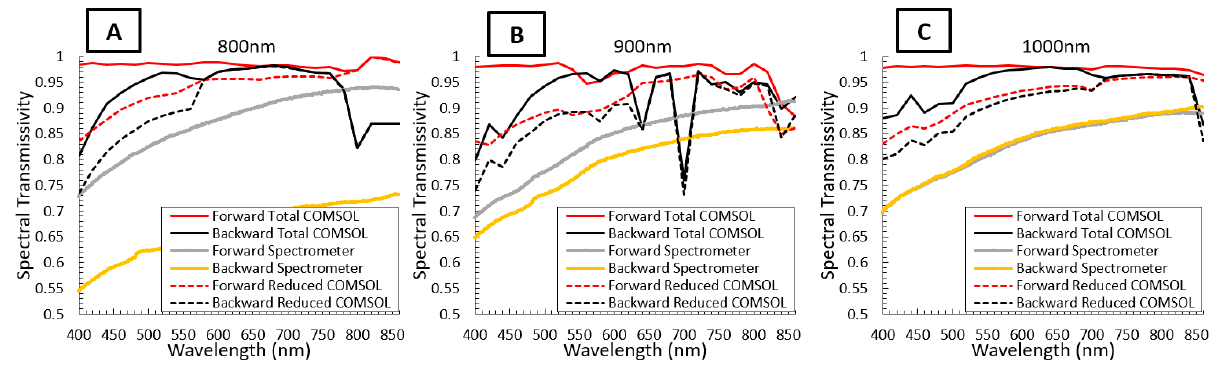
Figure 5 . Predicted total and reduced (m = ( − 2, − 1, 0, 1, 2)) transmissivity in the forward and backward direction for ( A ) 800 nm, ( B ) 900 nm, and ( C ) 1000 nm periodicity. Experimental data are added for comparison.